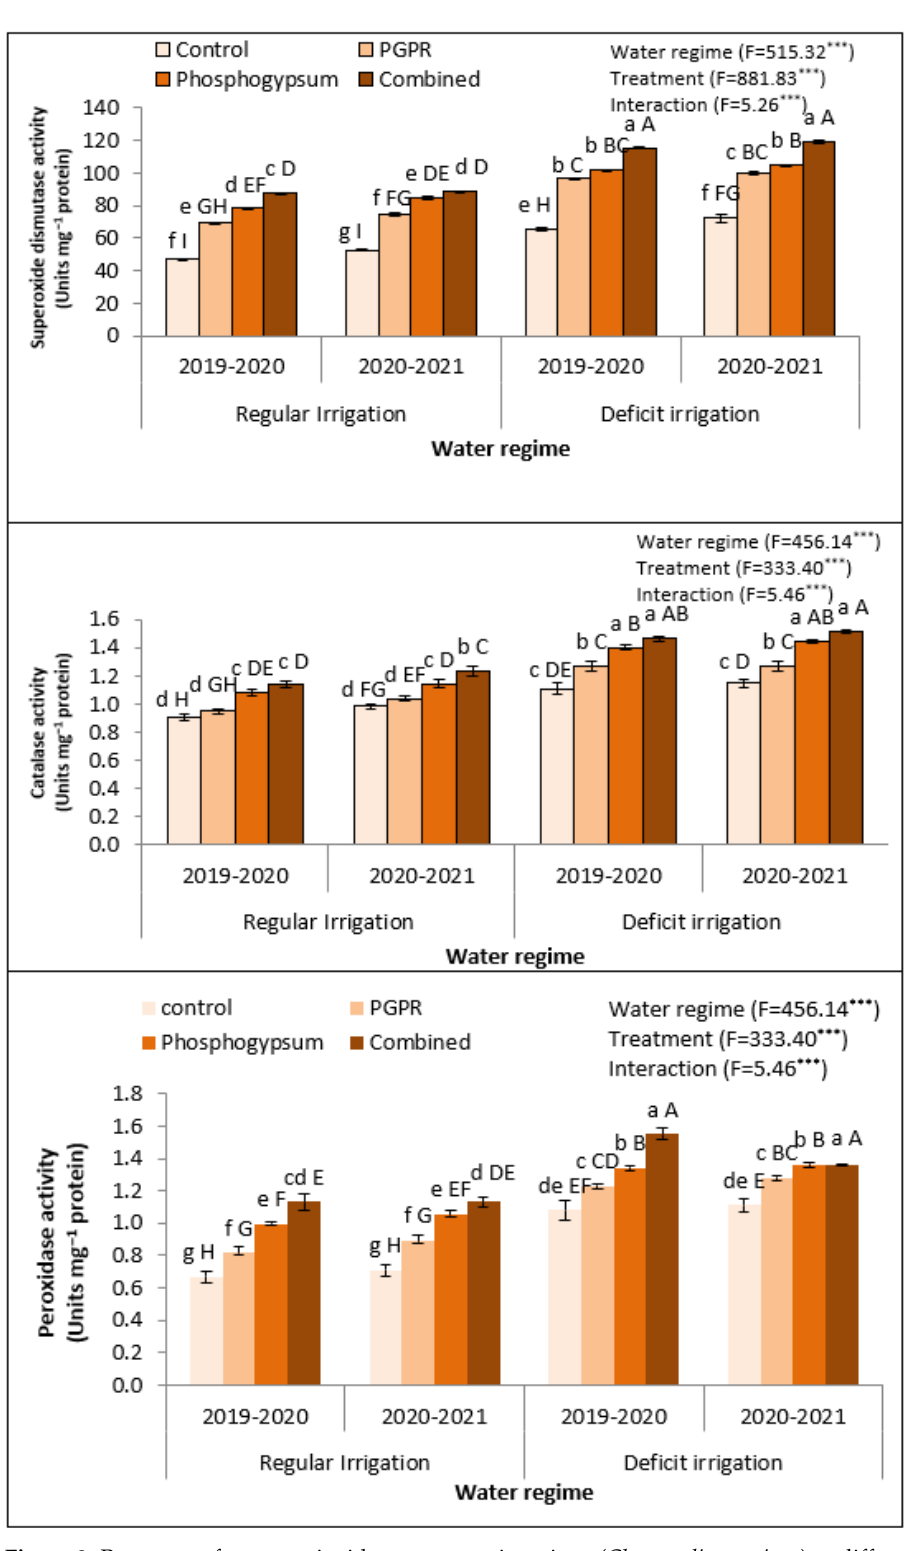
Figure 2. Response of some antioxidant enzymes in quinoa ( Chenopodium quinoa ) to different water regimes in the presence of singular or dual application of PGPR and phosphogypsum during two growing seasons (2019–2020 and 2020–2021). Different lowercase letters on the same columns of the same season are significant according to the Tukey’s test ( p ≤ 0.05) and different uppercase letters are significant regardless of the growing season according to the Tukey’s test ( p ≤ 0.05). Data are Means ± SD and n = 3. *** denotes significance at p ≤ 0.001.